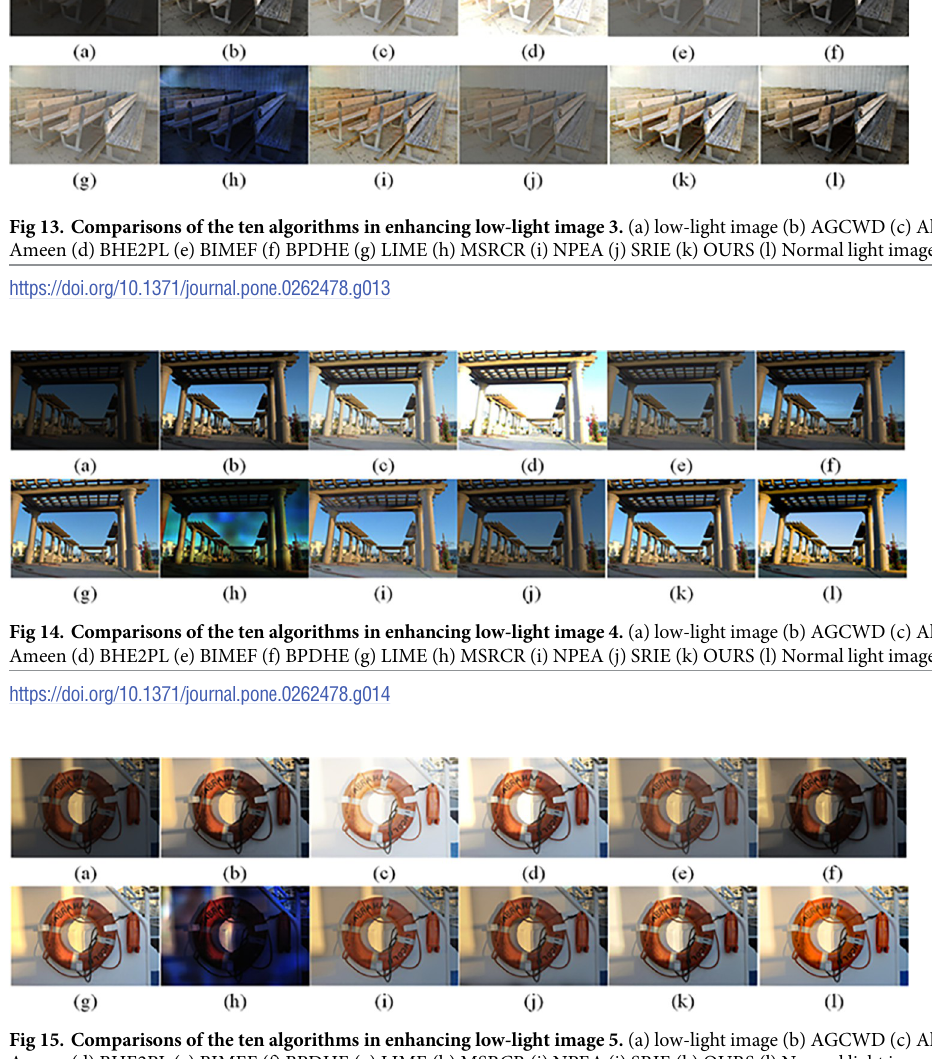
PLOS ONE | https://doi.org/10.1371/journal.pone.0262478 May 31,